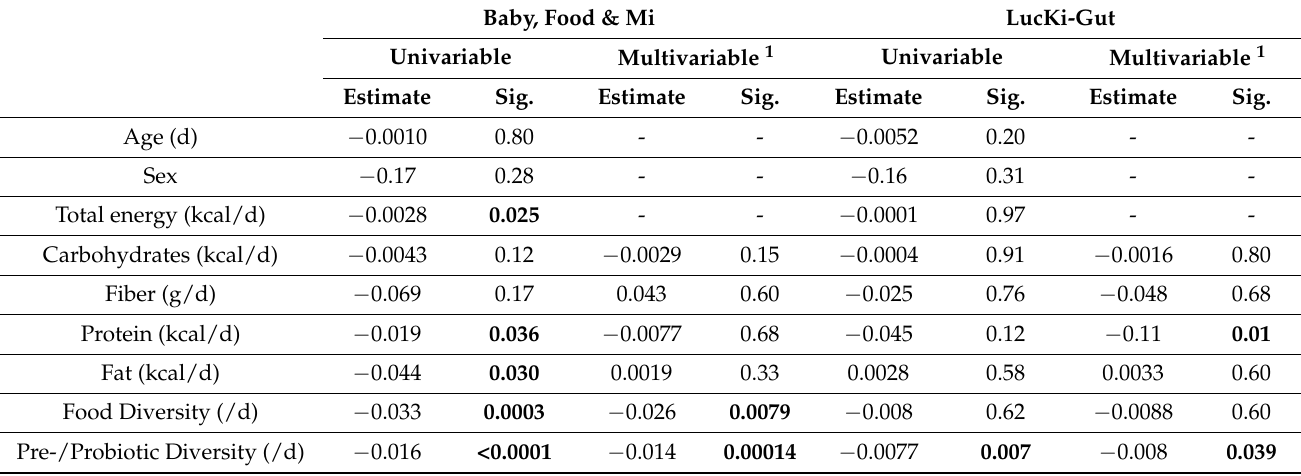
Table 3. Results of the generalized linear mixed effects model for sample-to-sample within-subject changes in microbial community structure (Bray–Curtis dissimilarity index) and the demographic/nutritional variables of interest for both